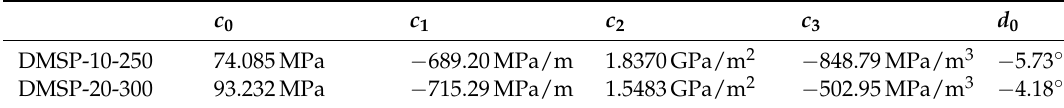
Table 2. Estimated parameters for F Martens ; optimization start point is given in Table 1.